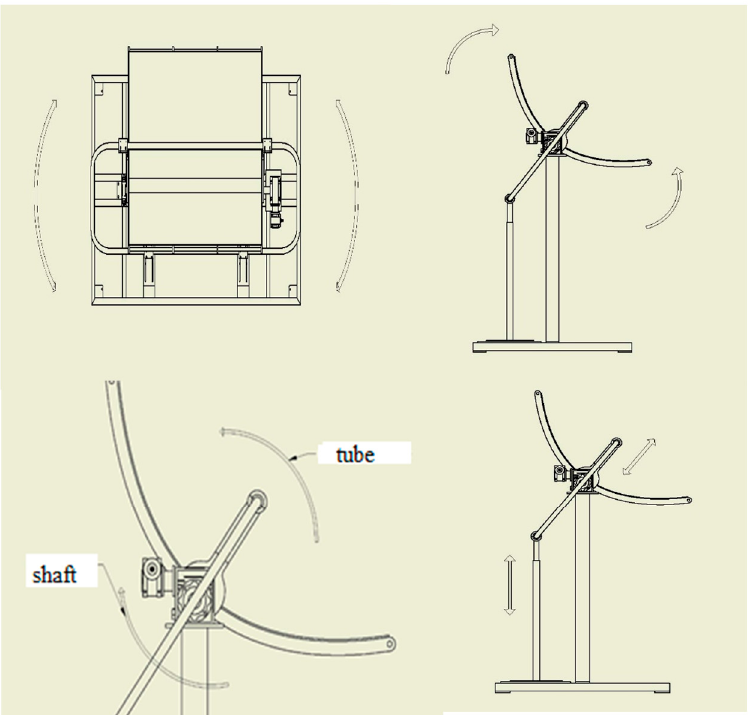
Figure 3. Degrees of freedom of the experimental plant.